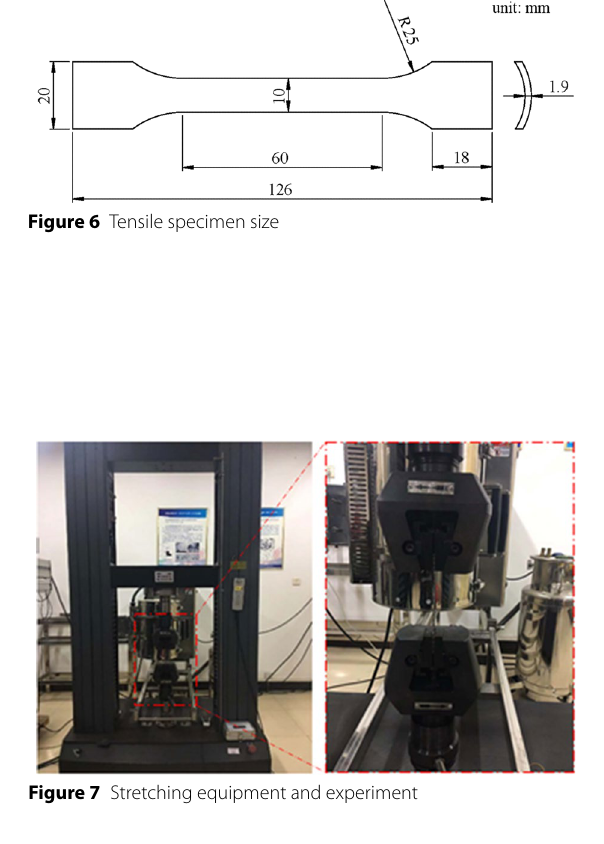
Figure 8 Tensile test